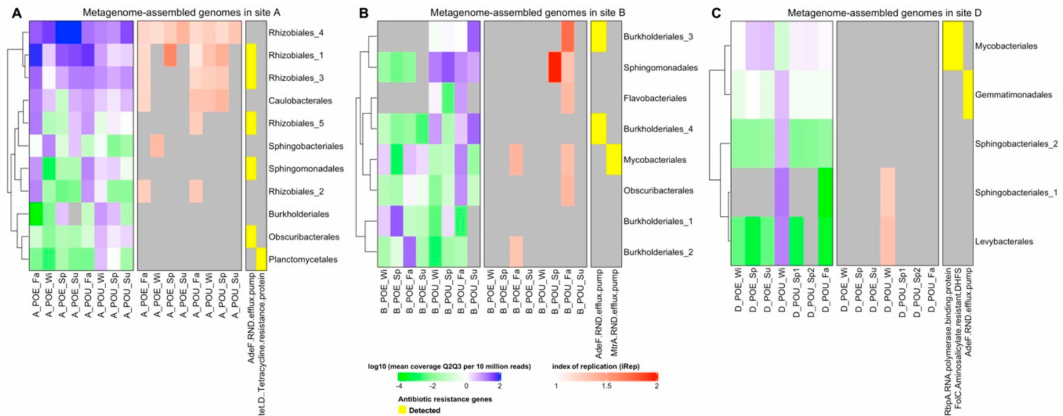
Figure 2. Metagenome assembled genomes (MAGs) from ( A ) site A, ( B ) site B, and ( C ) site D. Names of MAGs (row) are based on their classification at order level. Cell color in purple and green indicates relative abundance of each MAG, while the replication index is shown in shades of red. Positive presence of the mentioned antibiotic resistant genes (ARG) is indicated with a yellow